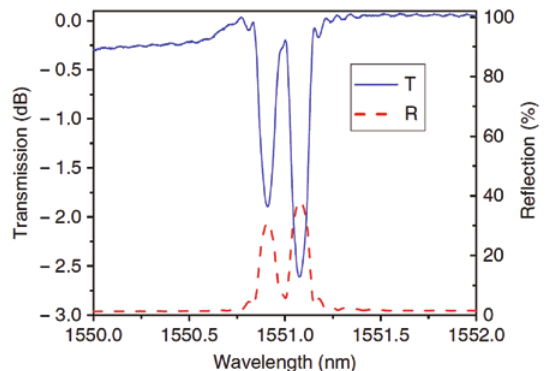
Figure 12: Spectral response of a PbP WBG written in boro-alumino- silicate glass. Peak splitting corresponds to a WBG birefringence of 1.9 × 10 − 4 . Reprinted with permission from